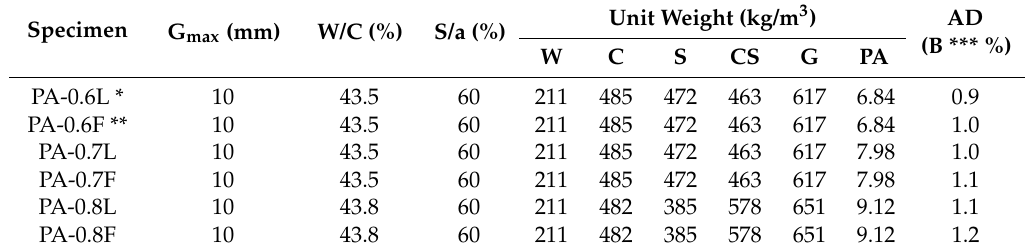
Table 5. Shotcrete mix design.